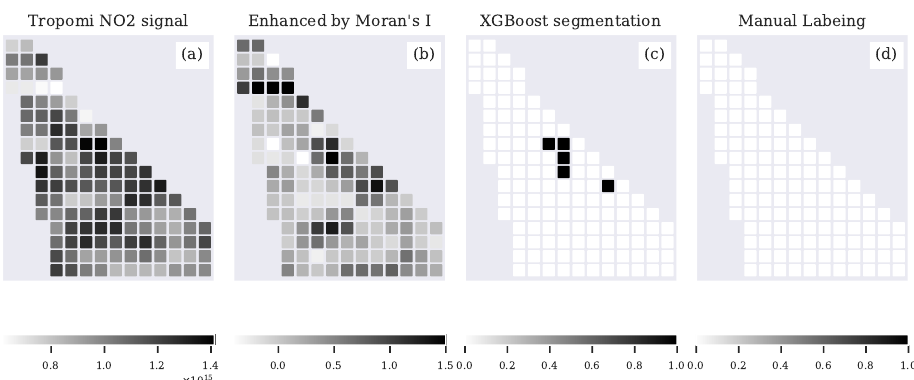
Figure 15. XGBoost classifier allows for the segmentation of plumes that were not recognized by the labeler. ( a ) TROPOMI NO 2 tropospheric vertical column density. Units: mol/m 2 . The variable was a part of the input to machine learning models. The ship plume is difficult to distinguish by the human eye. ( b ) TROPOMI NO 2 image enhanced by Moran’s I . The variable was a part of the input to machine learning models. After enhancement, the ship plume can be recognized better. At the top of the ship sector can be found an example when a cluster of low-value NO 2 was enhanced incorrectly. ( c ) Results of the segmentation of the XGBoost model. Black pixels indicate pixels classified by the model as a “plume”. ( d ) Human labels. The absence of black pixels means that there were no pixels within the area labeled as a plume. For all presented images, the size of the pixel is equal to 4.2 × 5 km 2 . Measurement date: 24 June 2019. Ship type: tanker. Ship length: 230 m. Average speed within the studied time scope: 14.27 kt.